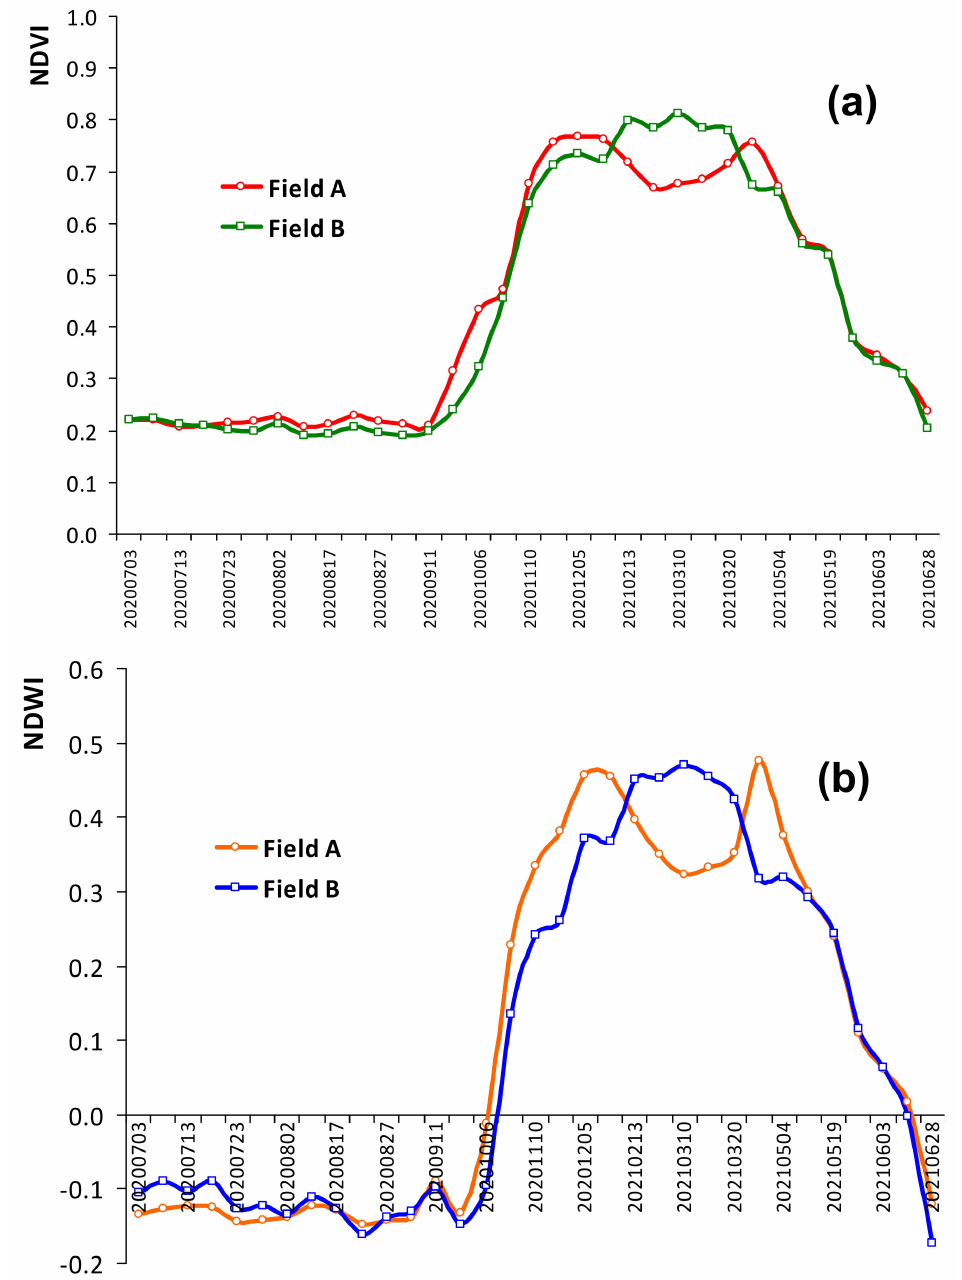
Figure 16. Pattern of normalized difference vegetation index (NDVI; ( a )) and ( b ) normalized dif- ference water index (NDWI; ( b )) obtained in sampling pixels of “Field A” and “Field B”